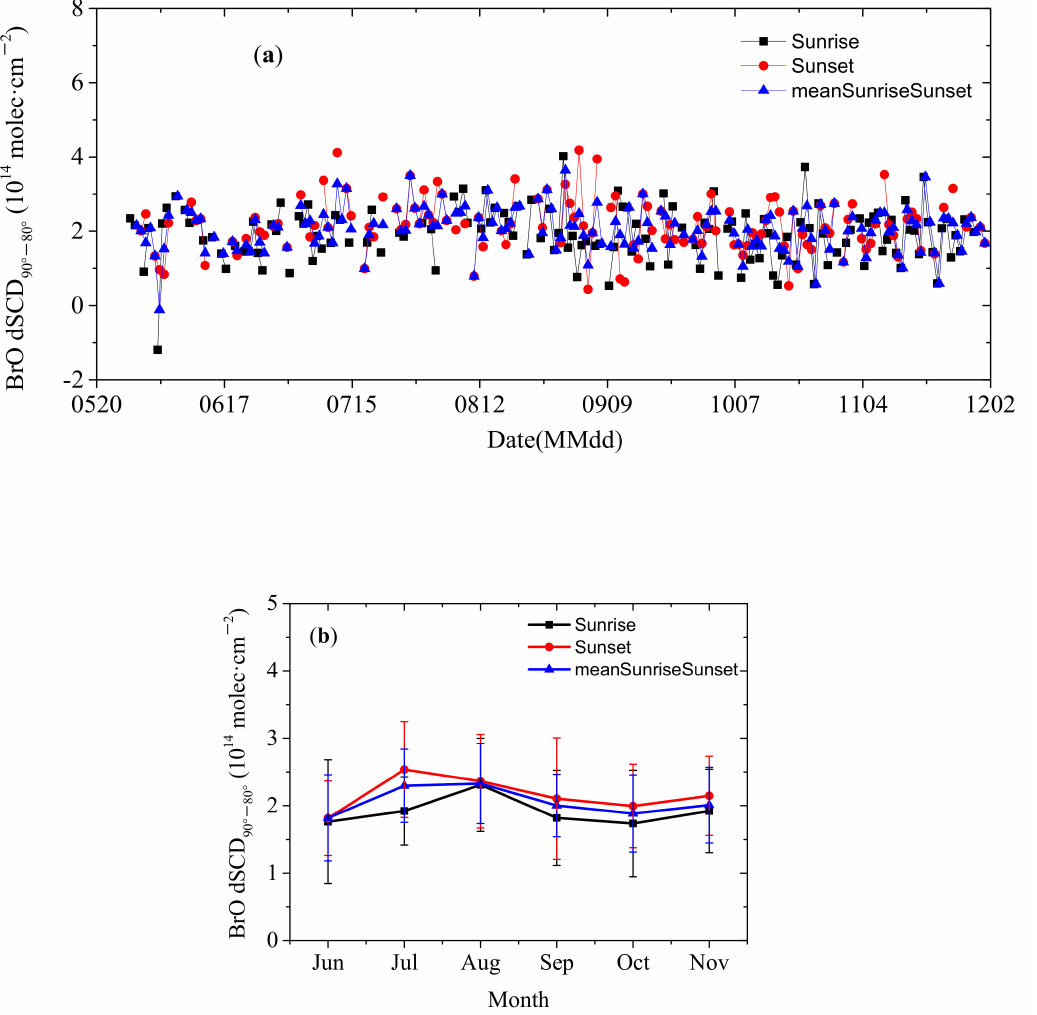
Figure 11. Temporal variation of the BrO dSCDs between 90 ◦ and 80 ◦ SZA. ( a ) Time series of the daily BrO dSCDs for sunrise (black curve with squares) and sunset (red curve with dots) as well as the mean value between sunrise and sunset (blue curve with triangles); ( b ) The monthly variation of the BrO dSCDs calculated from the daily BrO dSCDs. The error bars represent the standard deviations of the monthly mean BrO